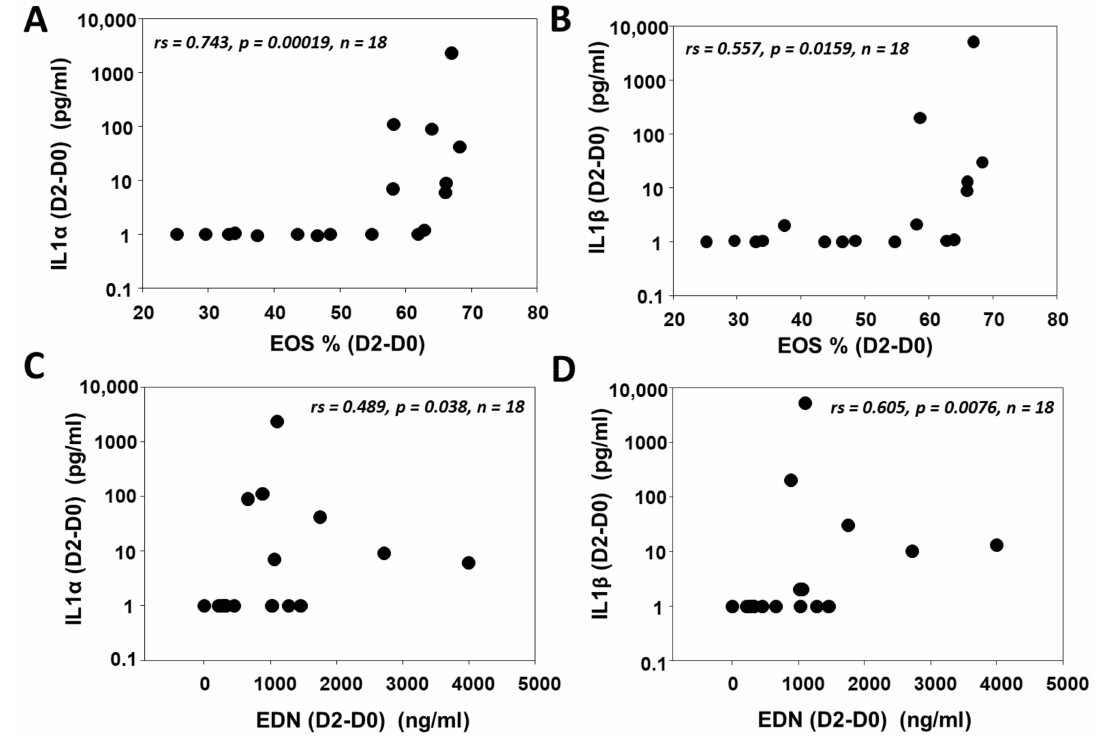
Figure 4. Eosinophilic inflammation is associated with IL1 α and IL1 β in bronchoalveolar lavage (BAL) after a segmental allergen challenge in allergic patients with mild asthma. ELISA against IL1 α ( A , C ), IL1 β ( B , D ) and eosinophil-derived neurotoxin (EDN) ( C , D ), as well as the quantification of purified eosinophils ( A , B ), was performed from BAL samples before segmental allergen challenge (SBP-Ag) (D0) and 48 h after the challenge (D2) (paired values from n = 18 subjects). Changes from D0 to D2 are presented for all variables. Spearman correlation was utilized for statistical analysis.